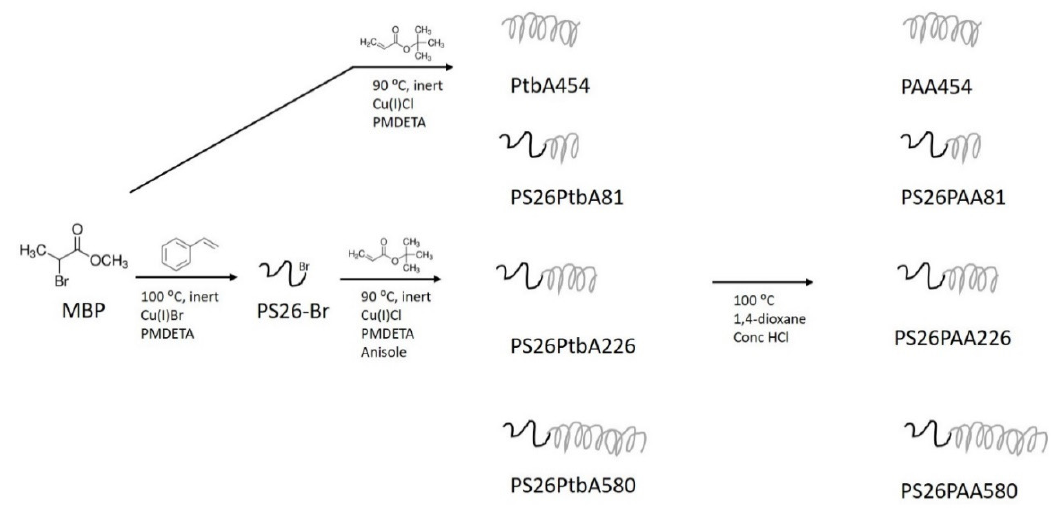
Figure 2. Process design for the synthesis of amphiphilic block copolymers used for the dispersion of multi-walled carbon nanotubes (MWCNTs). In the first step a polystyrene macroinitiator was made. Secondly, a chain of tert-butyl acrylate was formed in various lengths. The tBA groups were eventually hydrolyzed to form acrylic acid moieties.